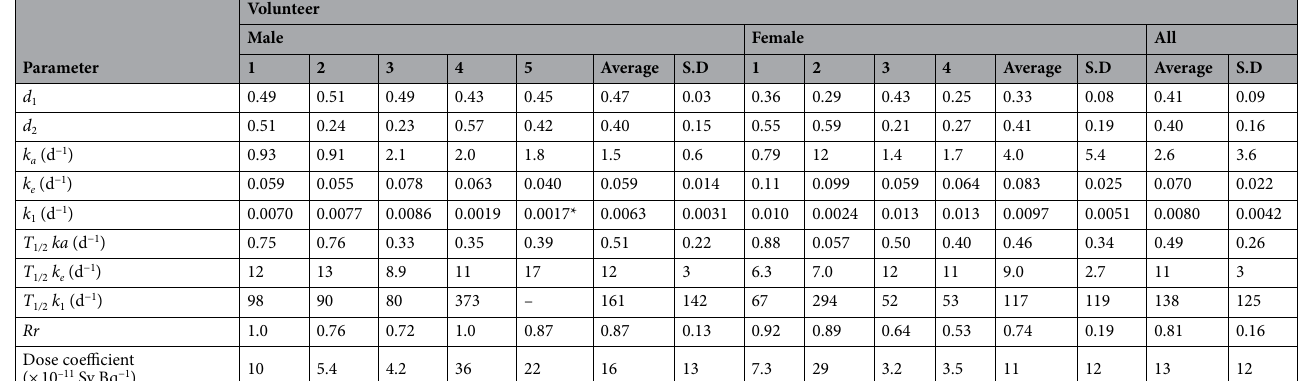
Table 4. Estimated parameters of OBD model for each volunteer administered with D-labelled palmitic acid. S.D., standard deviation. k a , transfer rate from digestive tract (DT) compartment to free water deuterium (FWD) and organically bound deuterium (OBD) compartments (d −1 ); k 1 , transfer rate from OBD